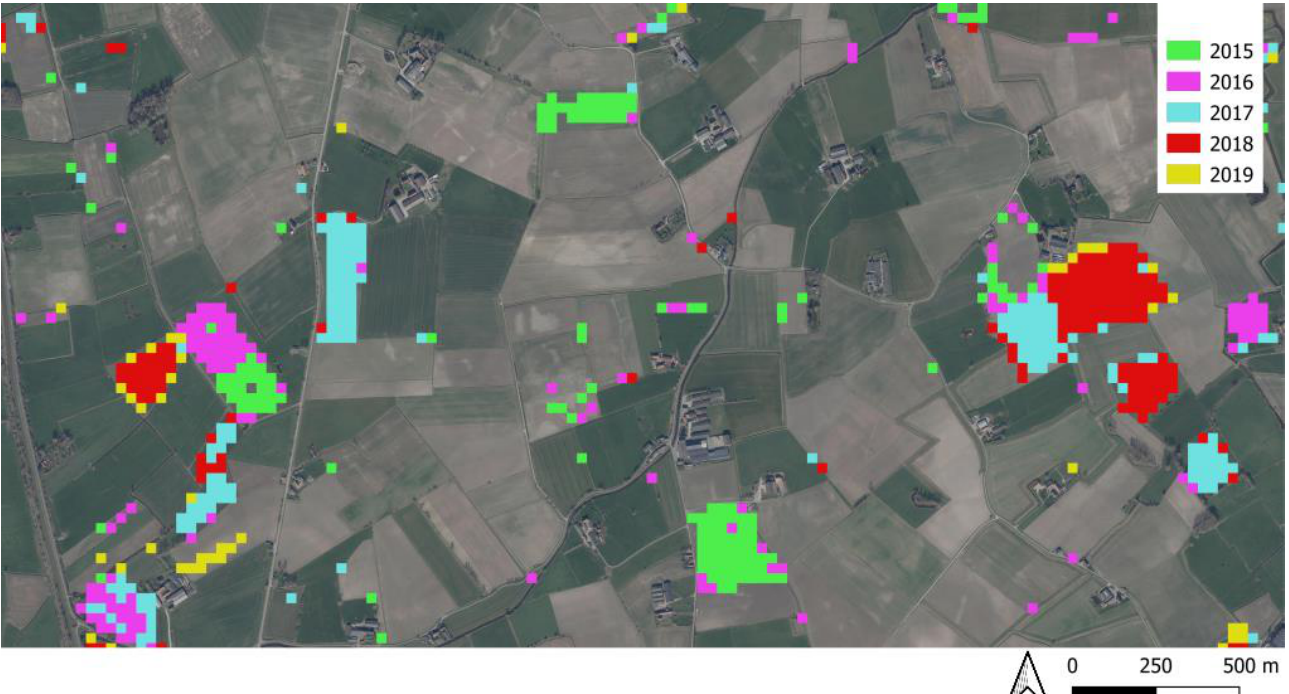
Figure 4. Location of grasslands that were grasslands from 2005 onwards but were converted to cropland between 2015 and 2019 according to the historical land cover classification maps. The colors indicate the year of conversion from grassland to cropland. Background orthophoto is from April 2021 [28].